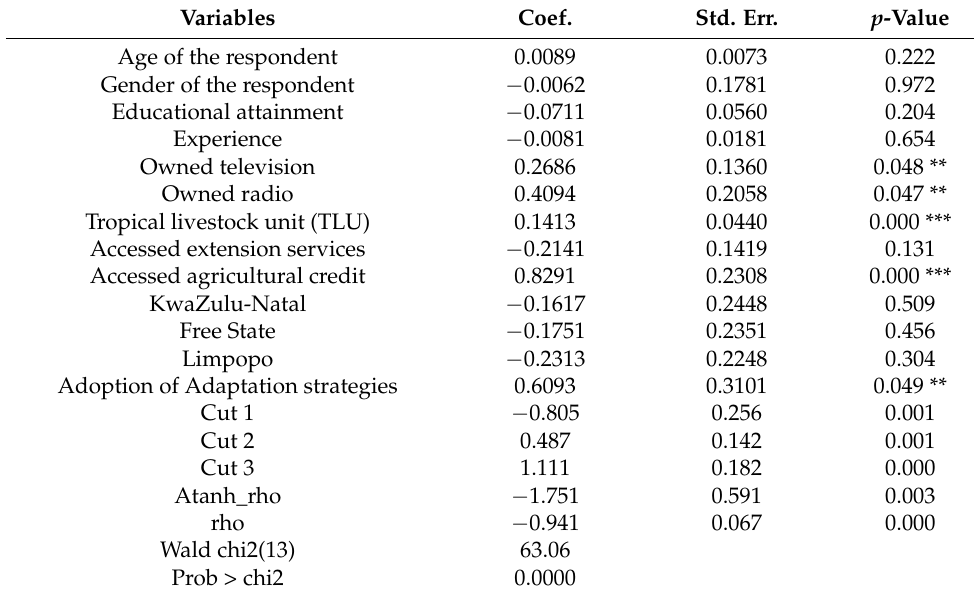
Table 3. Factors influencing households’ food